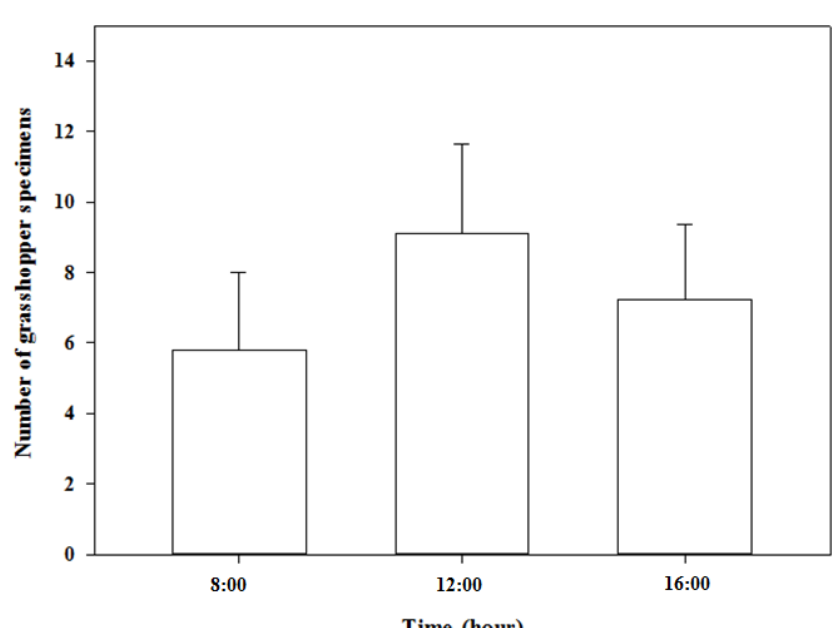
F IGURE 1. Mean±SE number of grasshoppers specimens captured in different times of day at rangeland site 1 in 2013.